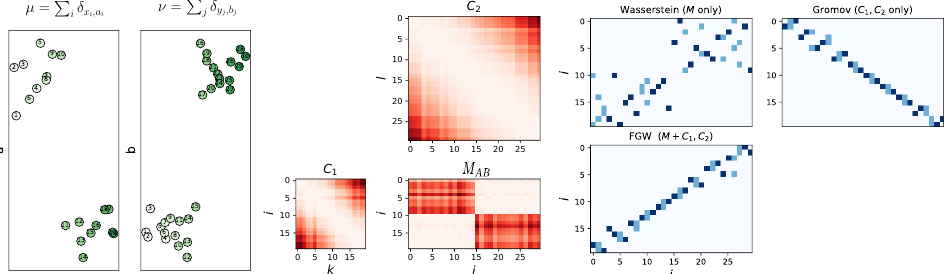
Figure 10. Illustration of the difference between W , GW , and FGW couplings. ( left ) Empirical distributions µ with 20 samples and ν with 30 samples which color is proportional to their index. ( middle ) Cost matrices in the feature ( M AB ) and structure domains ( C 1 , C 2 ) with similar samples in white. ( right ) Solution for all methods. Dark blue indicates a non zero coefficient of the transportation map. Feature distances are large between points laying on the diagonal of M AB such that Wasserstein maps is anti-diagonal but unstructured. Fused Gromov–Wasserstein incorporates both feature and structure maps in a single transport